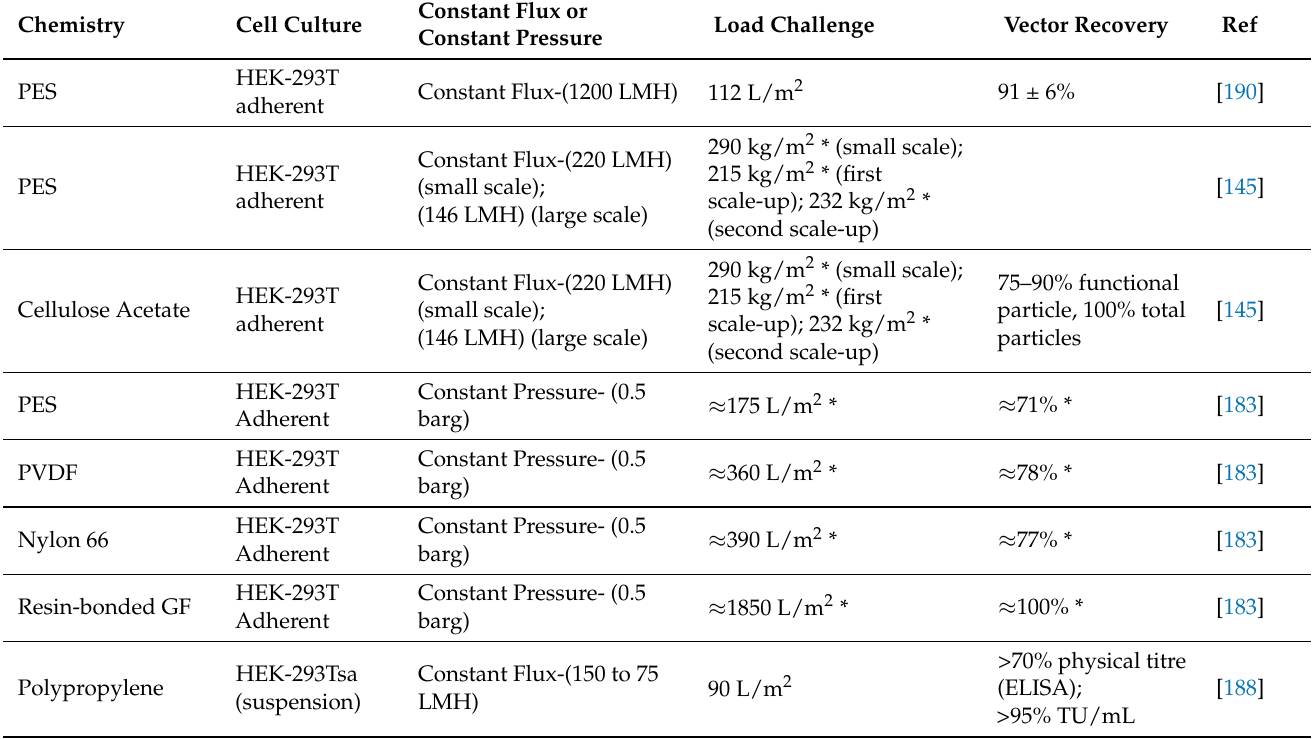
Table 5. Examples of filtration units for initial clarification of lentiviral